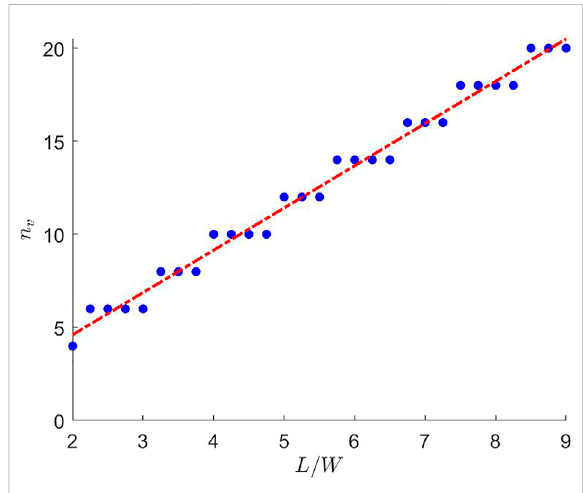
FIGURE 7 Scaling ofthenumberofvortices, n v ,inthe fl owvortexlattice state forstronganchoring as afunctionofthechannelaspectratio L / W . The blue points correspond to n v observed in numerical simulations ( ℓ κ = 0.01, ℓ η = 0.35, α = − 2.30) by increasing L/W in steps of 0.25 from L/W = 2 to L/W = 9. The value of n v increases in steps of 2, corresponding to the addition of a vortex/anti-vortex pair so as to maintain zero net vorticity. The growth is linear, as predicted by the simple scaling argument given in Section 3.3, but with a slope 2.270 ± 0.005 (dashed red line).